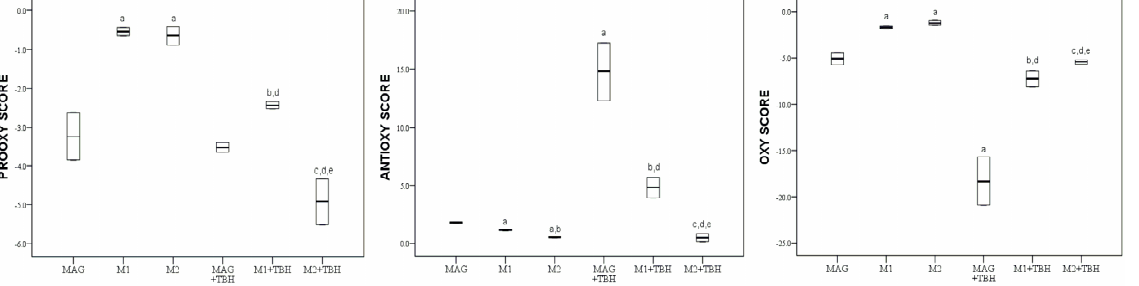
Figure 6. Values of pro-oxidative, antioxidative and oxidative scores of magnolol (MAG) and its two derivatives (M1, M2) in serum pool before and after the addition of TBH; values are represented by median (horizontal line) and interquartile range (25–75th percentile (lower and upper edge, respectively)). a,b,c,d,e—significant difference ( p < 0.05)compared to MAG, M1, M2, MAG + TBH, M1 + TBH, respectively.